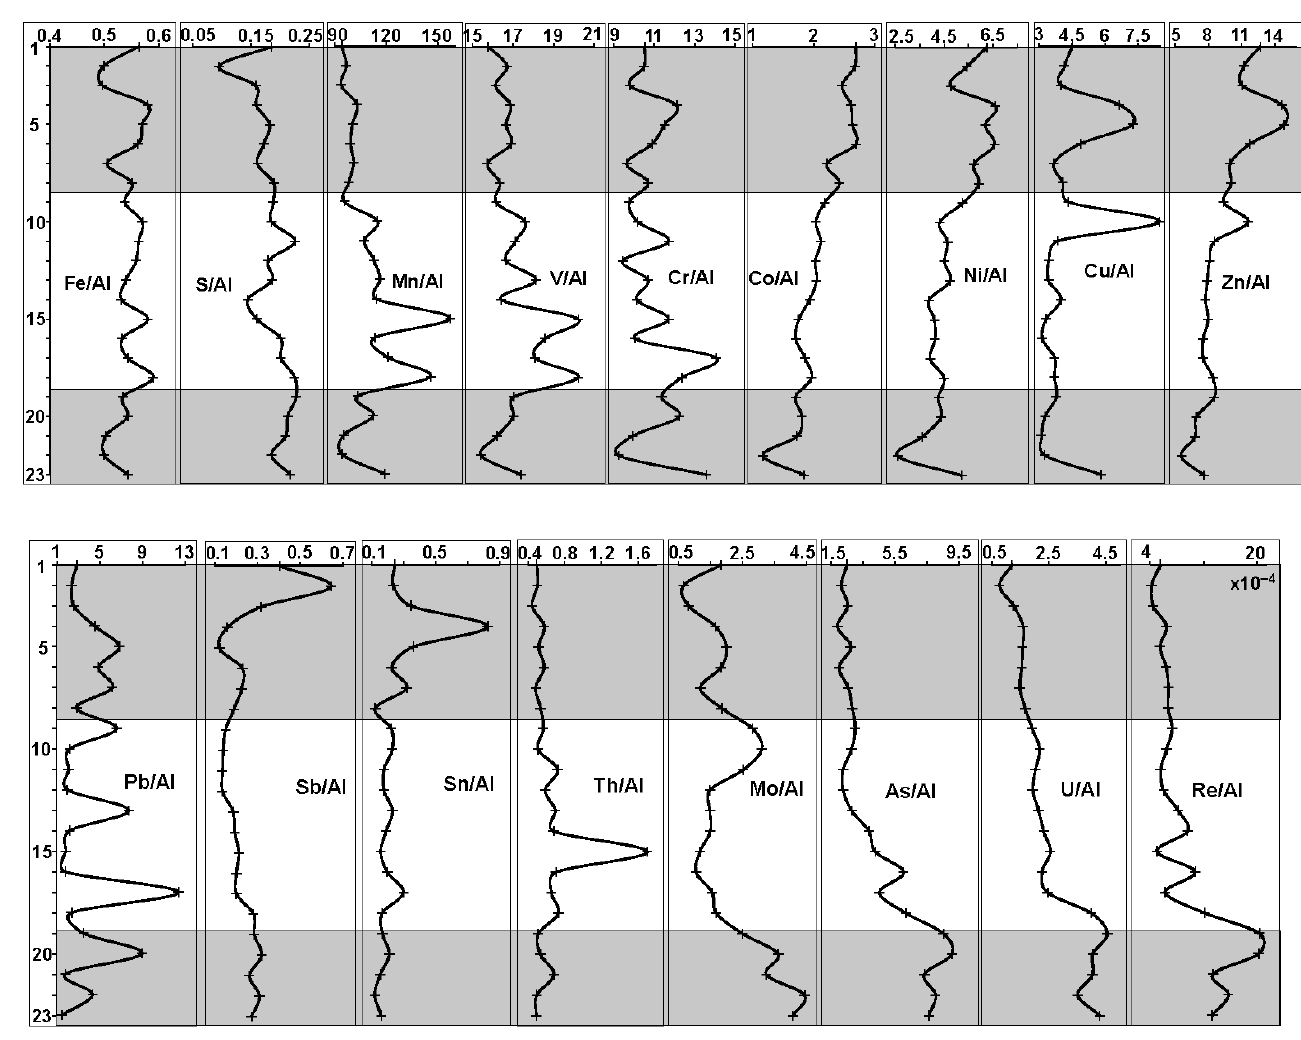
Figure 4. The vertical profiles of Al-normalized elements. Note the upcore increase in the Al-normalized Co, Ni, and Zn values, and the upcore decrease in the Mo/Al, As/Al, U/Al, and Re/Al values. Values of minor and trace elements are multiplied by 10 −4 .